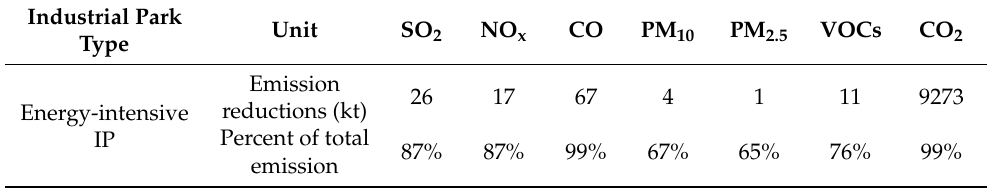
Table 3. Emission reduction potential of energy-intensive IPs.